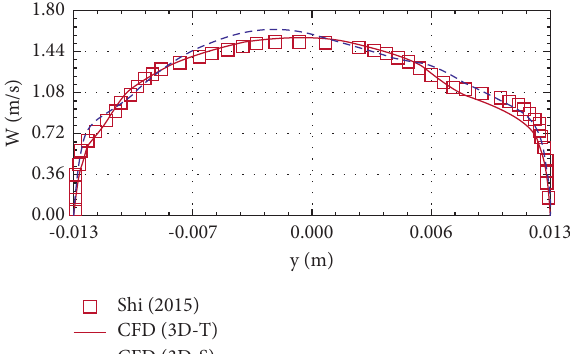
Figure 3: Comparison between the simulated axial velocity for mixture velocity 1.1m/s and the numerical results of Shi.